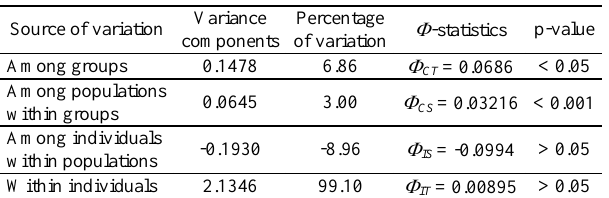
Table 5. Analysis of Molecular Variance (AMOVA) among populations of Brycon insignis (based in 1023 permutations). Structure tested: Group 1 (PCH); Group 2 (SFR); Group 3 (IMR, ITR, MUR and